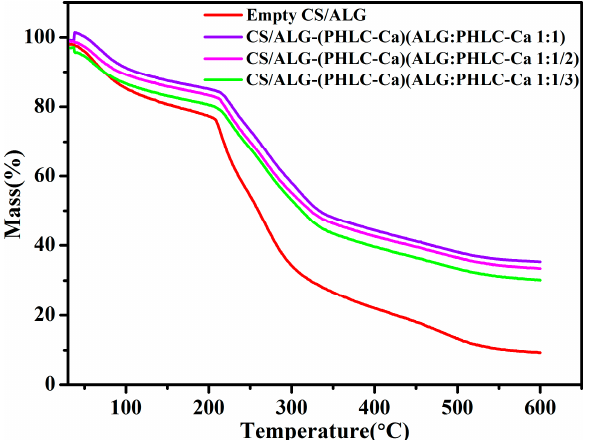
Figure 5. Thermal gravimetric analysis (TGA) curves of Empty CS/ALG and CS/ALG-(PHLC-Ca) microcapsules.